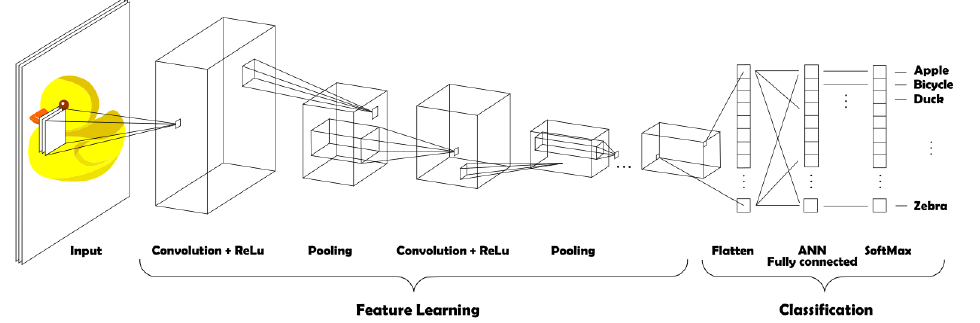
Figure 2. CNN process for an image classification problem: in the Feature Learning part, several convolutional layers alternate with pooling; in the Classification step, a fully connected ANN is used to define the output of the process (adapted from